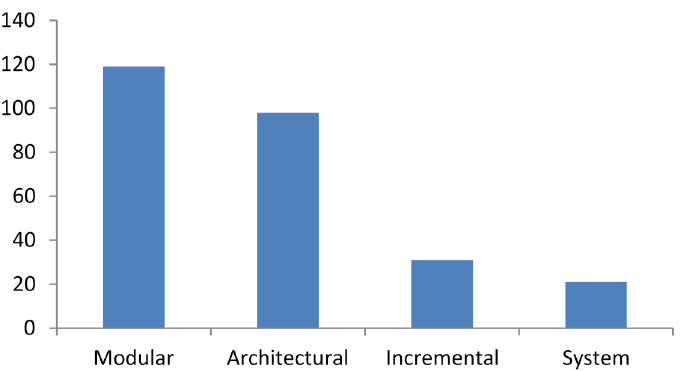
Figure 4. Innovation novelty categories that focused on delivering a single